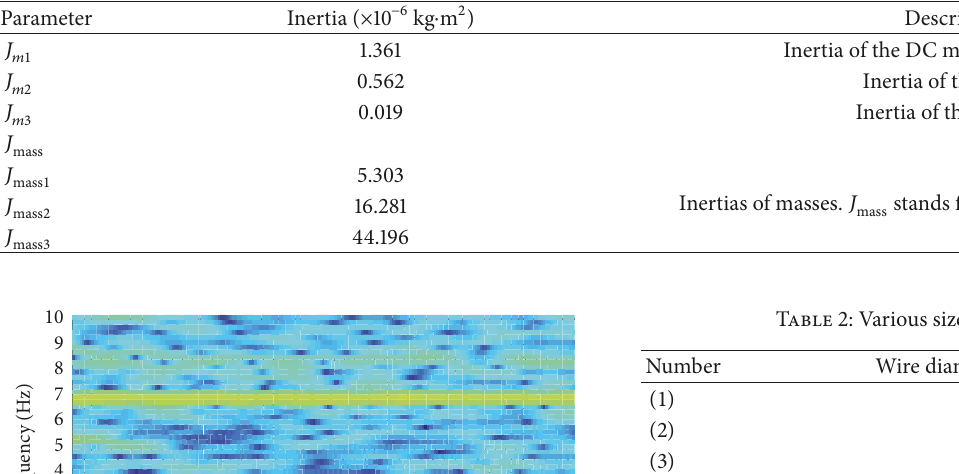
Figure 6: The velocity step responses of the drive side and the load side as well as their results of the FFT: (a) velocity step response of drive side, (b) velocity step response of load side, (c) FFT result of velocity step response of drive side, and (d) FFT result of velocity step response of load side. Table 1: Inertias of DC motor, coupler, stiff shaft, and three masses.